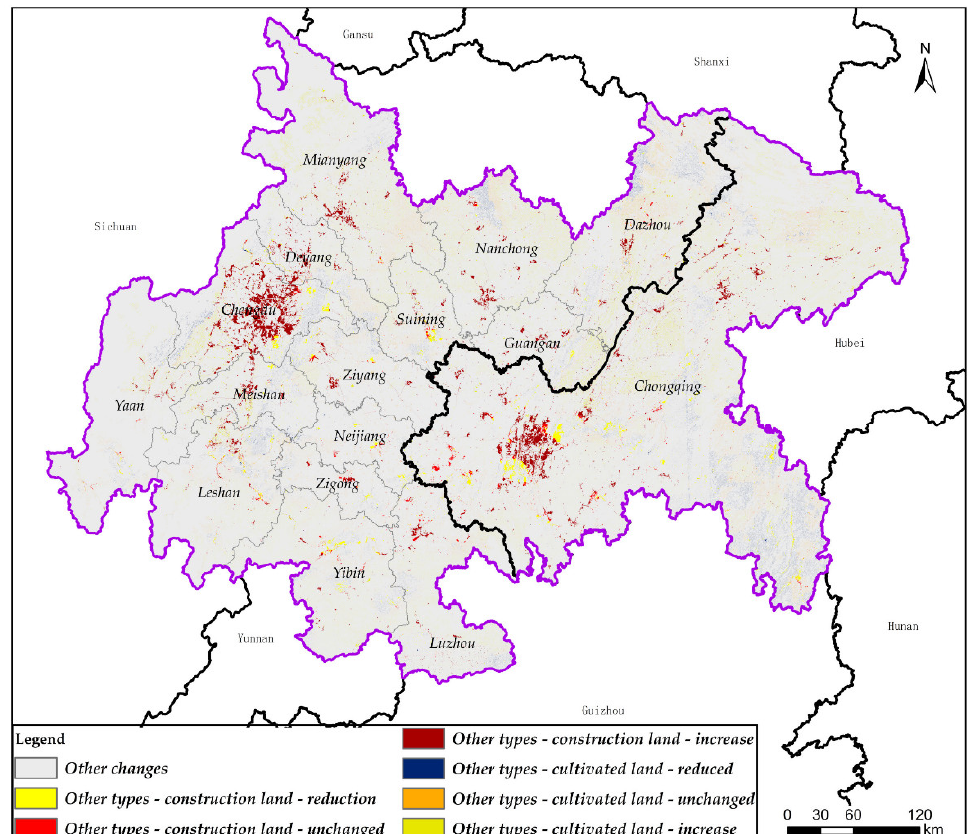
Figure 7. Land use type conversions and ecological risk changes from 2000 to 2020.